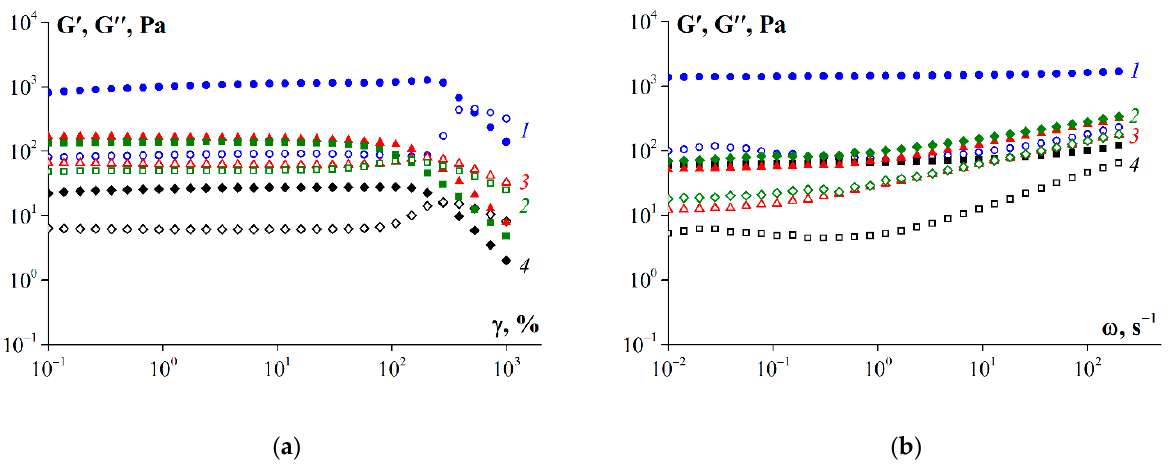
Figure 8. ( a ) Storage (G ′ , closed symbols) and loss (G ″ , open symbols) moduli dependency on amplitude at 6 °C and ω = 6.28 rad/s; ( b ) G ′ (closed symbols) and G ″ (open symbols) moduli dependency on frequency at 6 °C and γ = 1 %. 1—G1, 2—G2, 3—G3, 4—G 7041. Gelatin concentration was 10 wt.%.